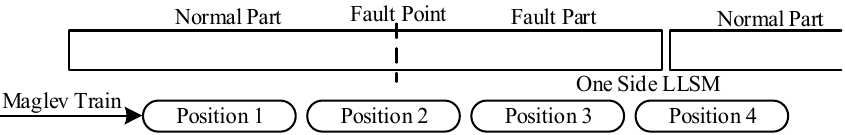
Figure 3. The process of Maglev train passing through three-phase short-circuit fault point.